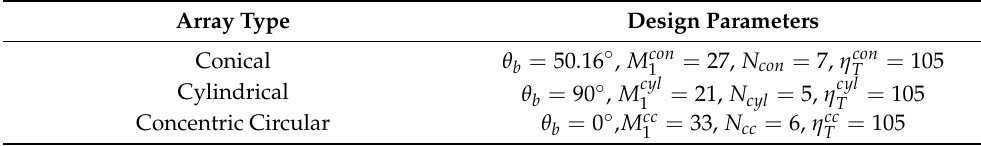
Table 2. Individual array design parameters for